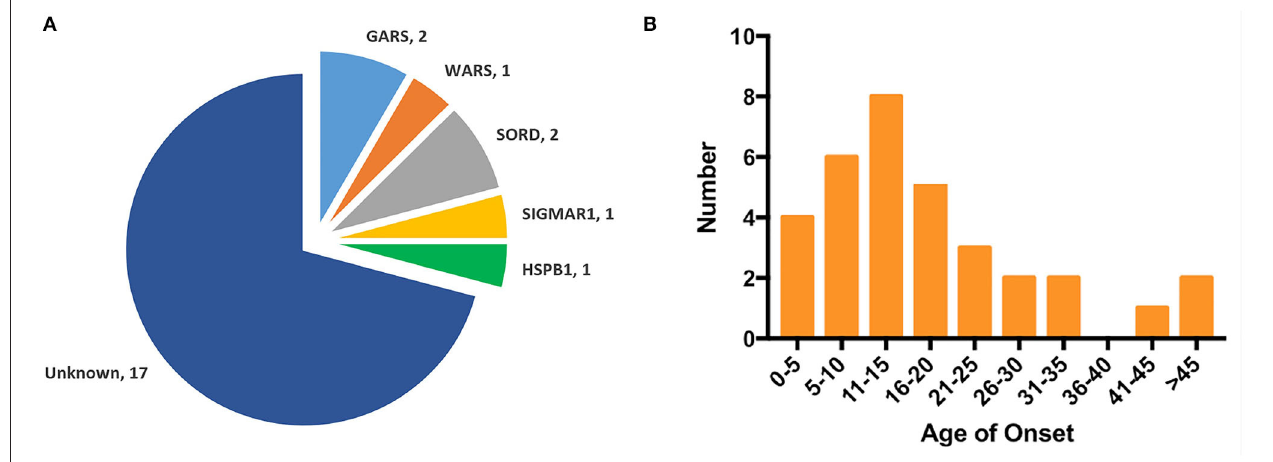
FIGURE 2 | Genotype distribution and age of onset distribution in Chinese dHMN families. (A) Of the 24 dHMN families, the diagnosis was genetically confirmed in seven and a total of six genotypes have been identified. (B) Of the total 33 dHMN patients in 24 families, 75.8% (25/33) reported disease onset in the first two